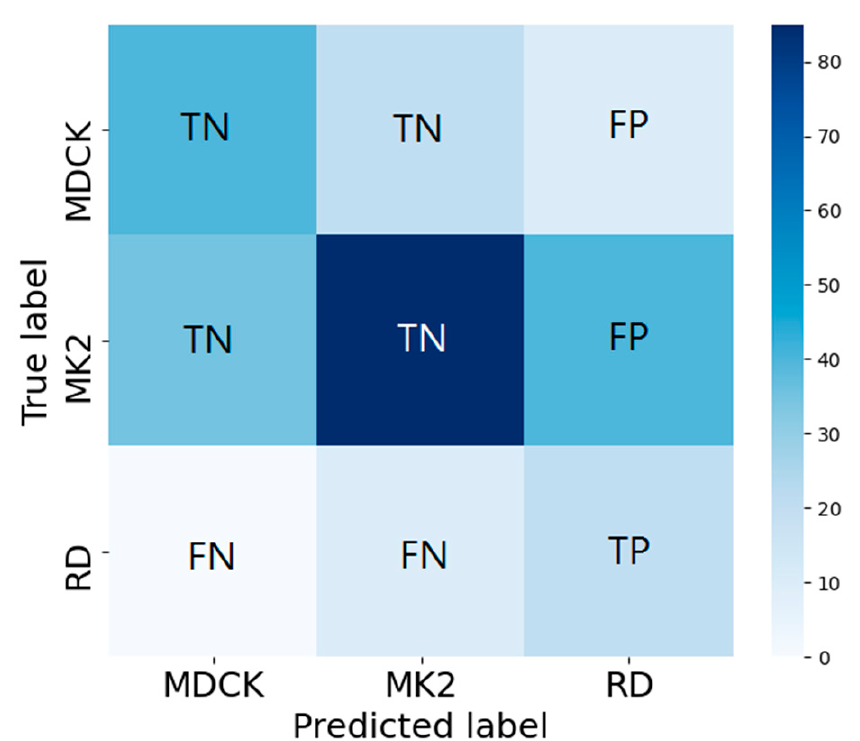
Figure 5. Confusion matrix analysis for precision, recall (Sensitivity), specificity, and F1-score. Here, RD is used as the target category to explain the calculations of the four indicators.